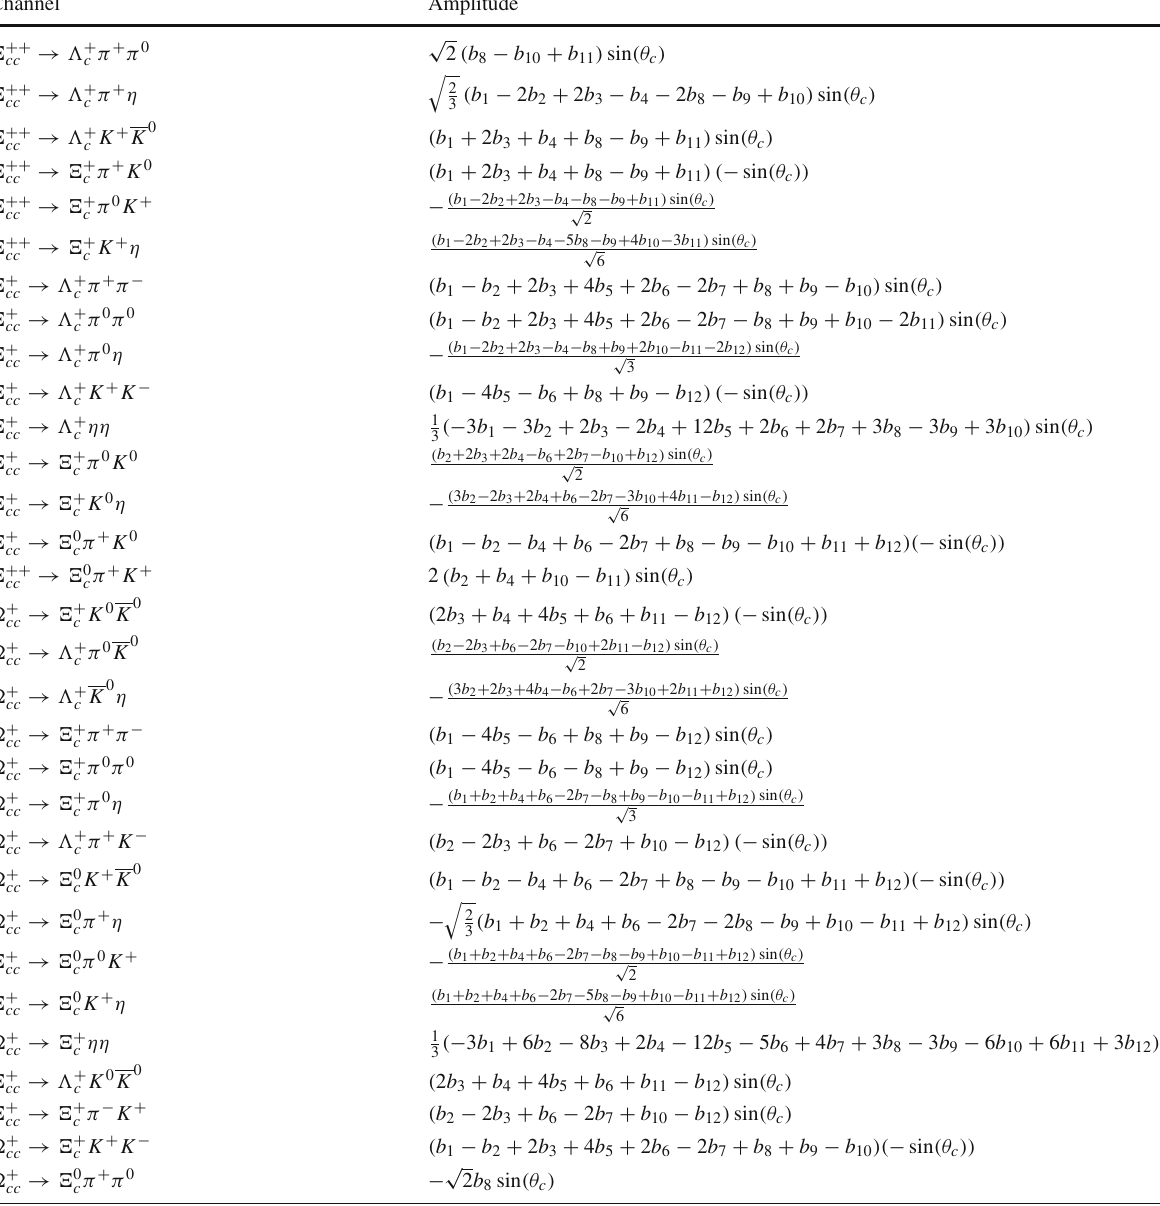
Table 7 Doubly charmed baryon decays into an anti-triplet cqq and two light mesons Channel